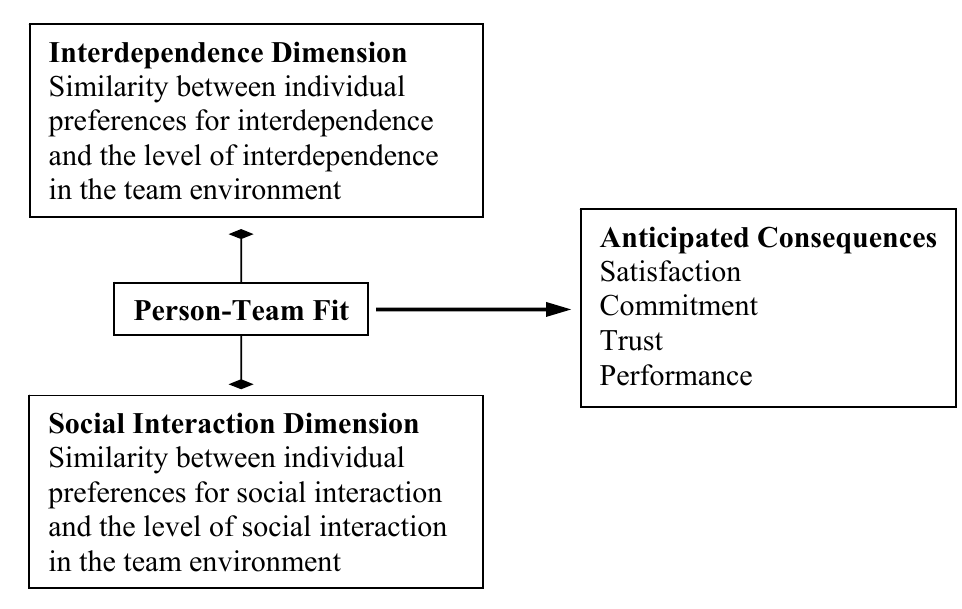
Figure 1. A model of person-team